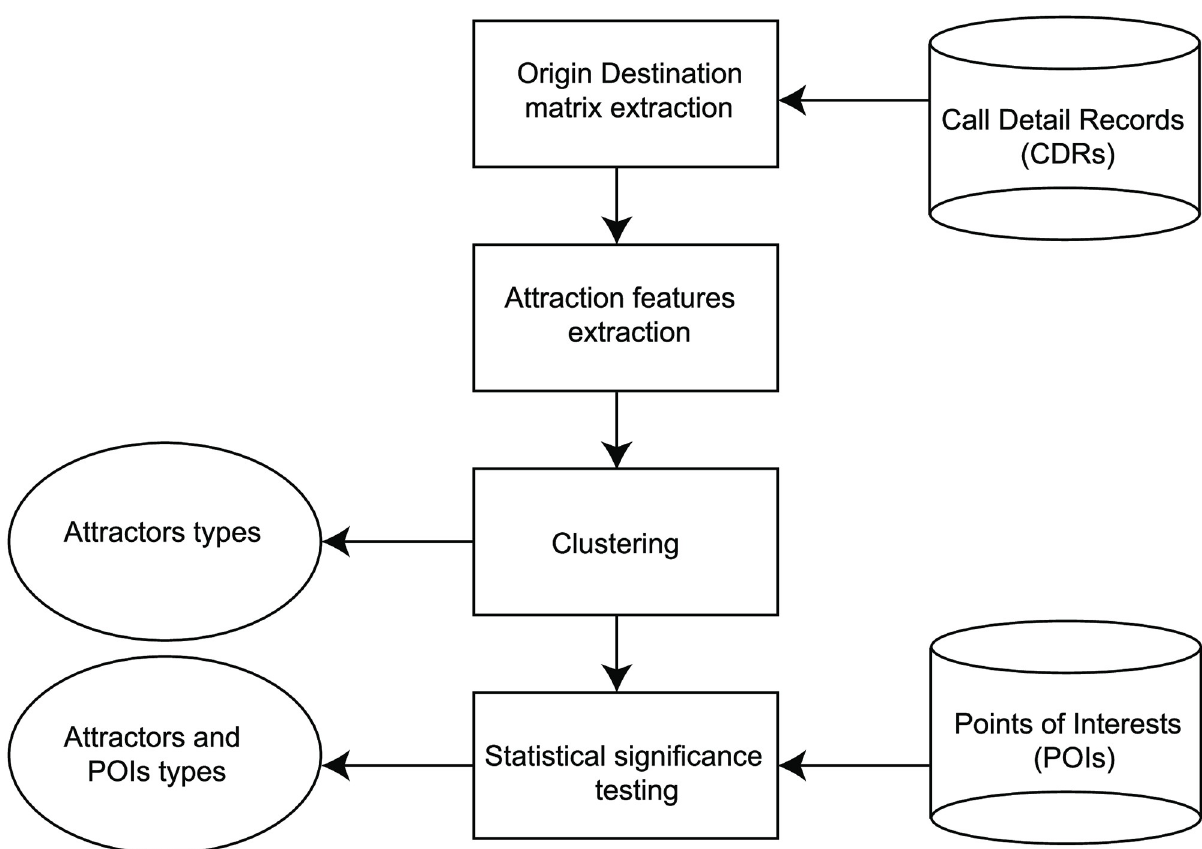
Fig 1. Urban attractors classification framework. It shows all sub-processes to identify attractor profiles. It relies on two data sources: Call Detail Records (CDRs) and Points of Interests (POIs) to detect attractors and relate types of places (POIs) to each attractor